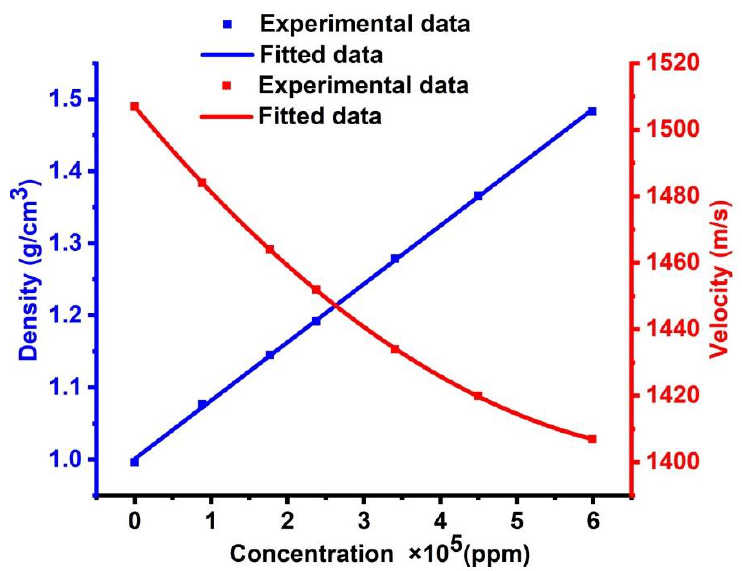
Figure 2. The effect of cadmium bromide concentration on its acoustic